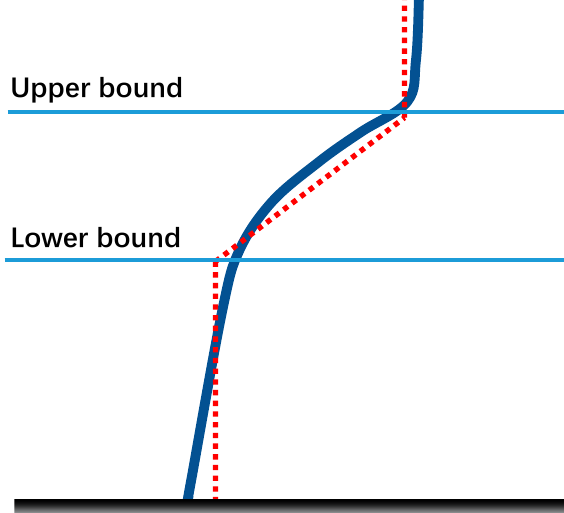
Figure 4. Schematic diagram for the quasi-step-function approximation. The thick blue line indicates the actual vertical temperature profile, the red dash line indicates the fitted three-segment temperature profile. The top and bottom perpendicular segments present the surface and bottom mixed layers; the oblique segment presents the thermocline.